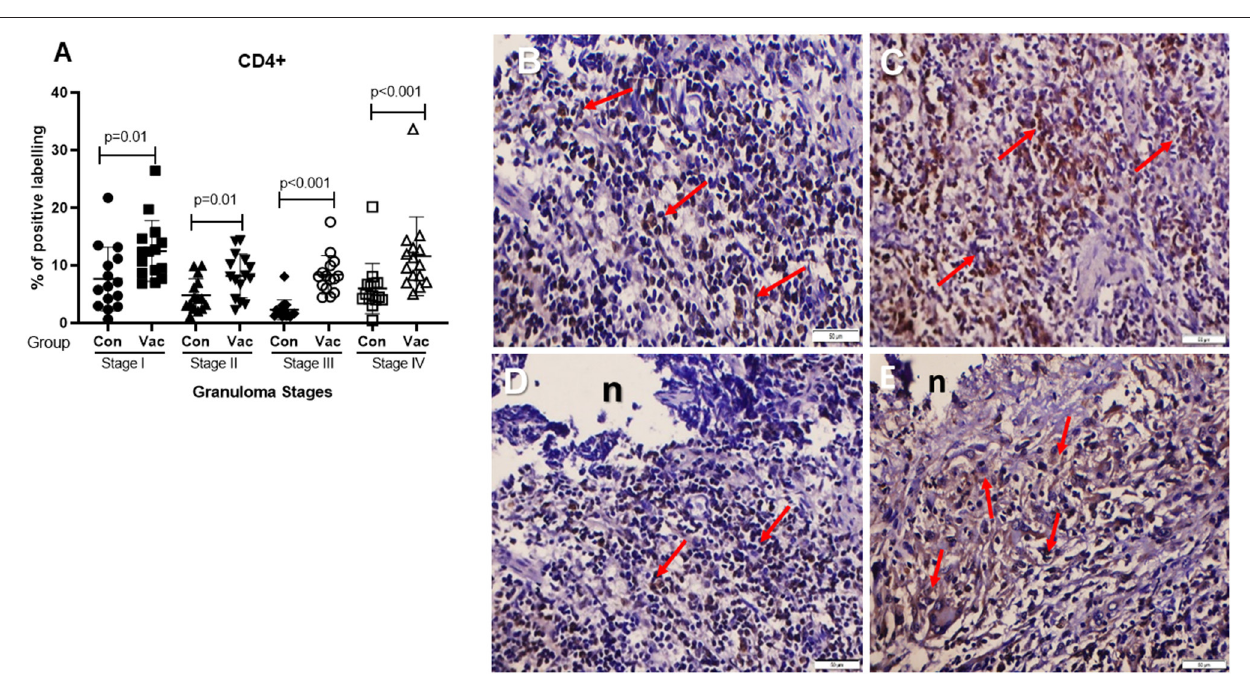
FIGURE 1 | Immunolabeling for CD4 + cells (ABC IHC stain, DAB brown chromogen). (A) Comparison of CD4 + cell distribution in different granuloma stages of BCG vaccinated (Vac, vaccinated) and non-vaccinated (Con, control) calves. (B) Stage I granuloma from non-vaccinated calves, showing stained CD4 + cells (arrows). (C) Stage I granuloma from BCG vaccinated calf showing more CD4 + cells (arrows). (D) Stage IV granuloma from non-vaccinated calf showing stained CD4 + cells (arrows). (E) Stage IV granuloma from BCG vaccinated calf showing stained CD4 + cells (arrows). Bar equals 50 µ m in (B–E) . n, necrotic